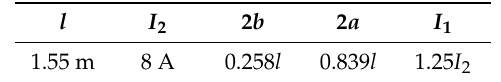
Table 3. Key parameters of the coil.